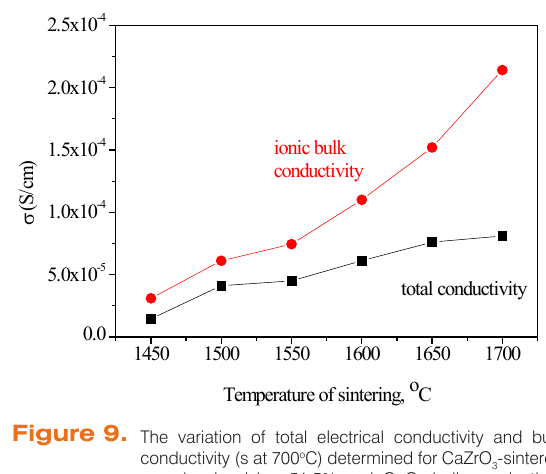
Figure 9. The variation of total electrical conductivity and bulk conductivity (s at 700 o C) determined for CaZrO samples involving 51.5% mol CaO; bulk conductivity determined by the AC impedance spectroscopy method, total conductivity determined by the DC four-probe method.